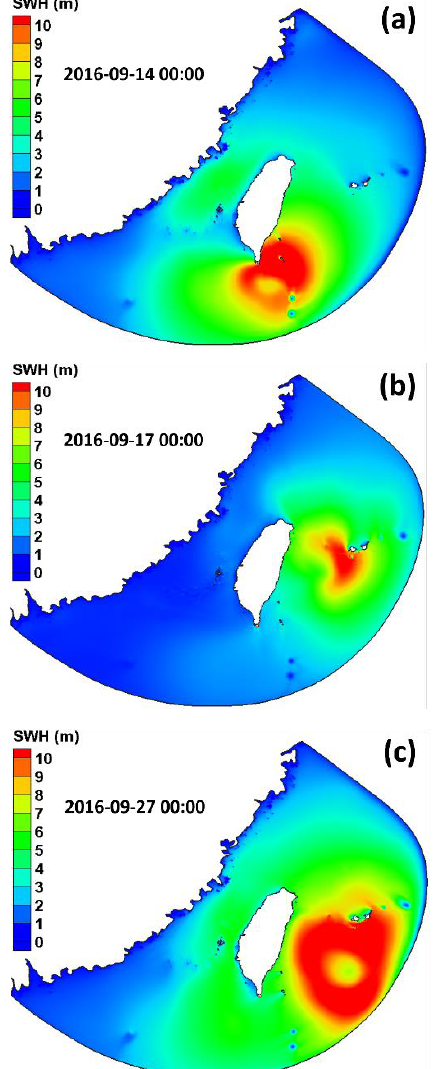
Figure 8. Spatial distribution of the simulated significant wave height at ( a ) 00:00 on 14 September 2016, ( b ) 00:00 on 17 September 2016, and ( c ) 00:00 on 27 September 2016, using the D01 computation domain and ERA5 wind fields.